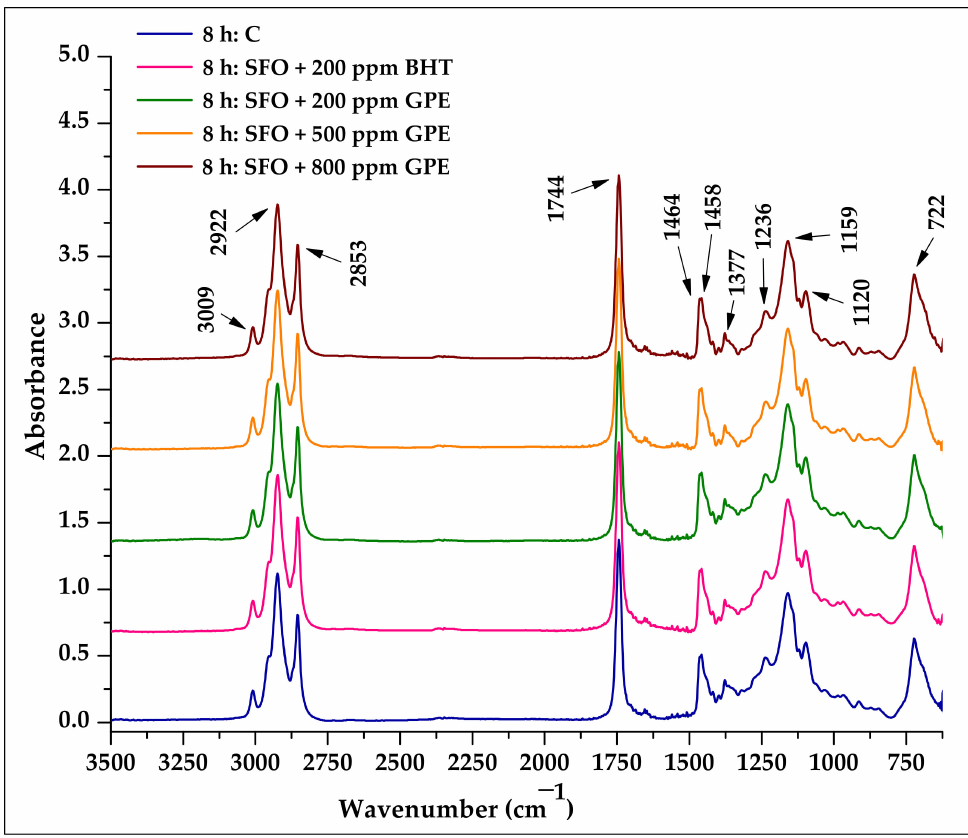
Figure 5. ATR-FTIR spectra of sunflower oil samples supplemented with BHT and GPE compared with the control sample after 8 h of heat